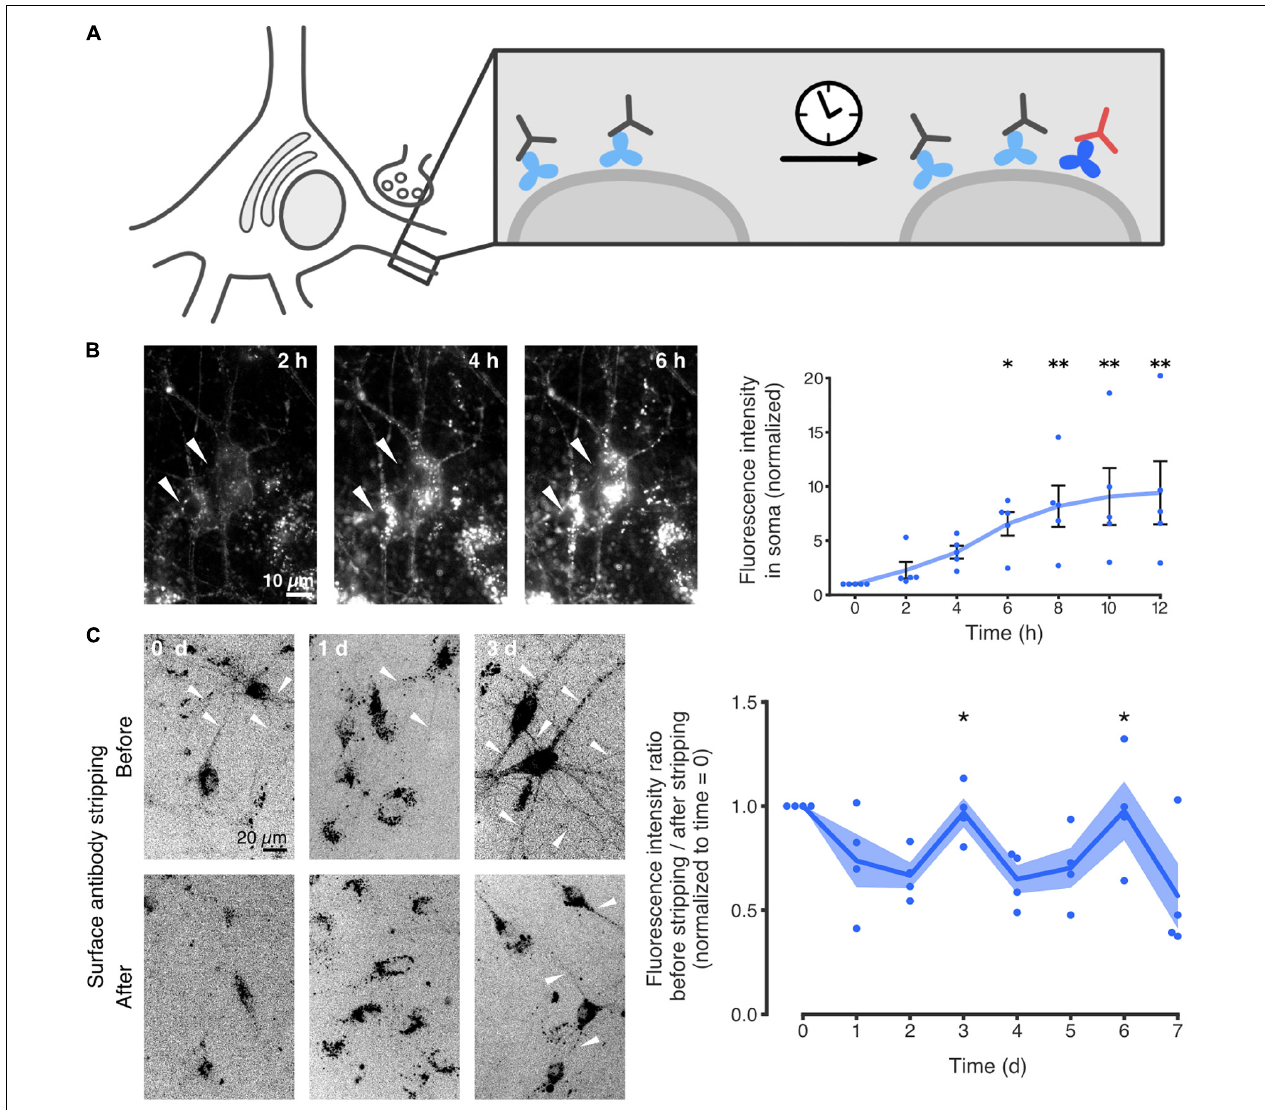
FIGURE 3 | TNR internalization and recycling in hippocampal neurons. (A) Schematic of the experimental assay for the labeling of recycling molecules. Live cultured neurons were incubated with non-fluorescent antibodies (gray) to block all of the surface TNR epitopes (light blue). After a period of time (4–6 h), the neurons were incubated with fluorophore-conjugated TNR antibodies (red) to label any “newly emerged” TNR epitopes which were not present at the neuronal surface beforehand (dark blue). Since the half-life of TNR in these cultures is ∼ 7 days (Dörrbaum et al., 2018), the amount of newly synthesized TNR molecules that emerge at the surface should not be significant. The fluorescently labeled TNRs can be subsequently followed in imaging experiments. (B) Time-lapse imaging of newly emerged TNR epitopes over 12 h. It is evident that the TNR epitopes are accumulating in the neuronal somas (two examples are indicated by the white arrowheads), demonstrating a significant internalization of these molecules. Scale bar = 10 µ m. The plot shows a quantification of the mean TNR fluorescence intensity in multiple neuronal somas, normalized to the intensity at t = 0 h. A visible increase over 12 h is observed, confirming the observation that the molecules are internalized. N = 5 independent experiments, with 1–4 neurons each. Statistical significance was evaluated using the Friedman test ( χ 2 6 = 25.46, *** p < 0.001), followed by Dunn’s multiple comparisons test (* p = 0.033, **p = 0.005, ** p = 0.005 and ** p = 0.002 for the 6, 8, 10, and 12-h timepoints, respectively). (C) The proportion of newly emerged TNR epitopes at the neuronal surface was measured over 6 days, by imaging before and after a treatment with proteinase K to strip away cell-surface molecules. Immediately after labeling (“0 days”), virtually no neurites were visible after stripping, indicating that the majority of the newly emerged TNR molecules are at the surface. On day 1, the stripping had little effect, indicating that many TNR molecules had internalized. On day 3, neurites were once again visible before but not after stripping, indicating that a large amount of TNR molecules had returned to the neuronal surface. Scale bar = 20 µ m. The plot shows a quantification of the fluorescence ratio before/after stripping, normalized to t = 0 days. The peaks at days 3 and 6 indicate that TNR recycles with a periodicity of ∼ 3 days. N = 4 independent experiments. Statistical significance was evaluated with the Kruskal-Wallis test (days 2–4: H 2 = 8.29, ∗ p = 0.016, days 4 – 6: H 2 = 6.74, ∗ p = 0.036), followed by Fisher’s LSD (“3d” vs. “2d”: ∗ p = 0.046; “3d” vs. “4d”: ∗∗ p = 0.005; “6d” vs. “5d”: ∗ p = 0.022; “6d” vs. “7d”: ∗ p = 0.028). All data represent the mean (lines) ± SEM (panel B : whiskers; panel C : shaded regions), with dots indicating individual experiments. Adapted from Dankovich et al. (2021) with permission